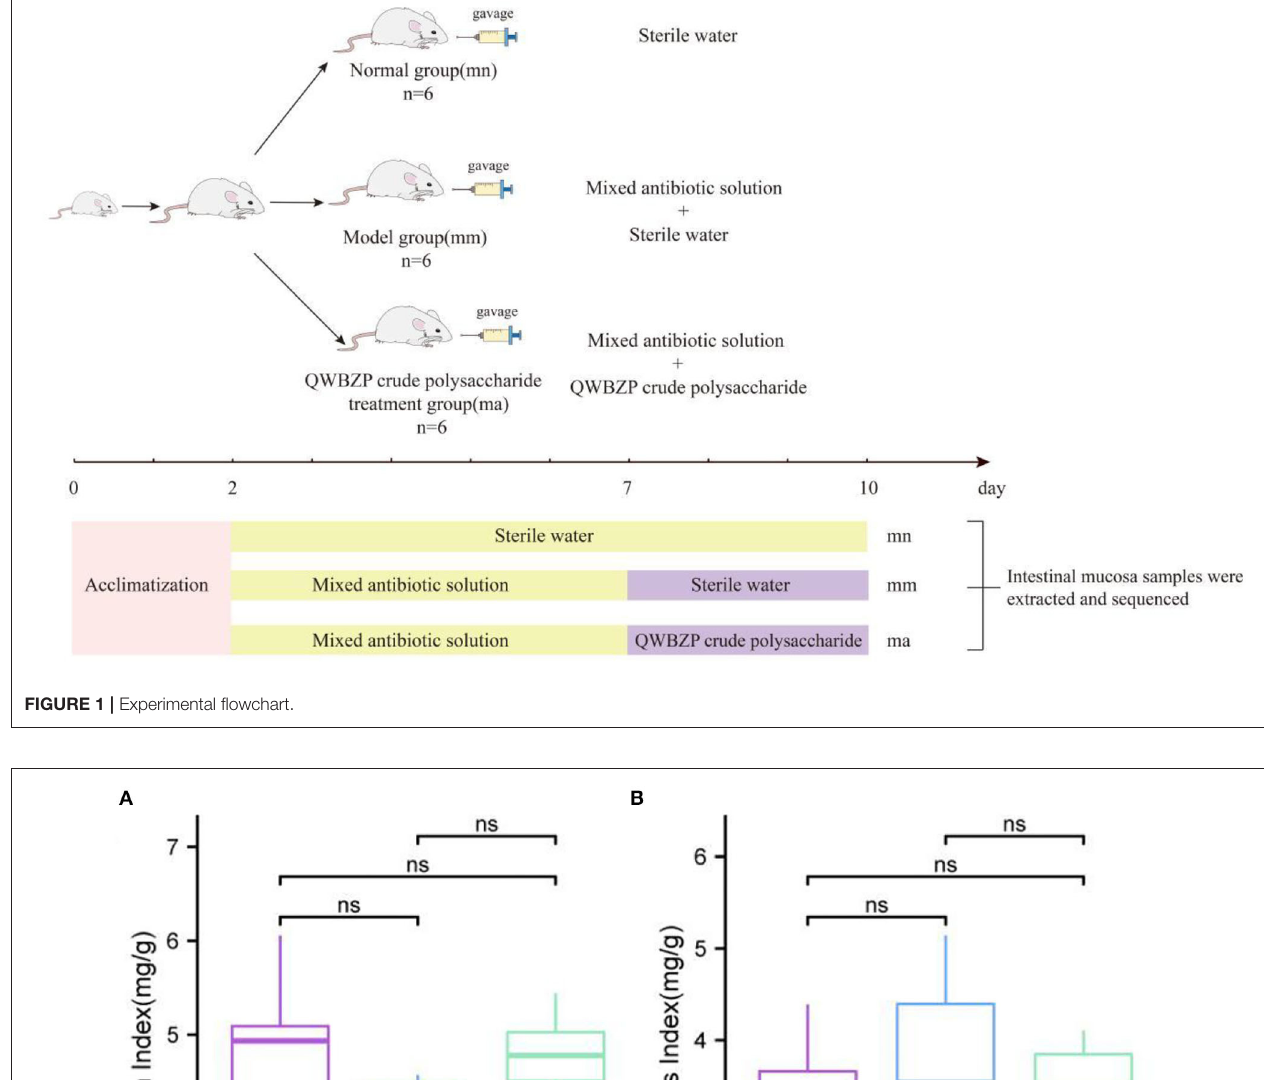
FIGURE 2 | Comparison of the spleen index and the thymus index. Box plots of (A) spleen index and (B) thymus